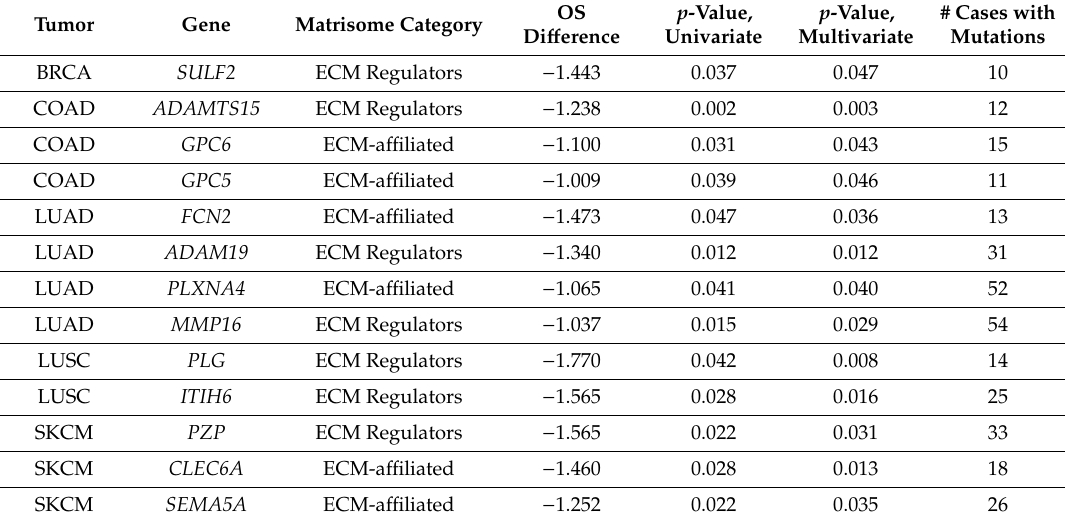
Table 4. Mutated genes encoding extracellular matrix regulators or a ffi liated proteins impacting patient